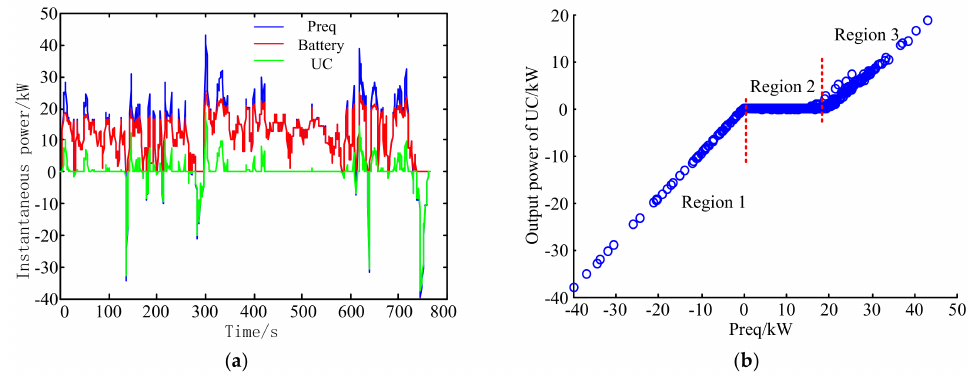
Figure 9. HWFET driving cycle. ( a ) Instantaneous power allocation; ( b ) Power